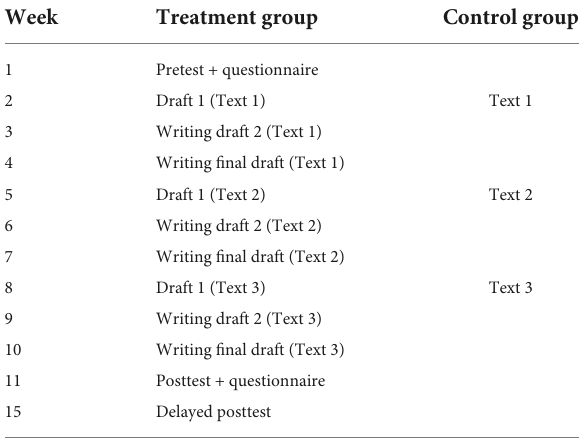
TABLE 2 Procedures of data